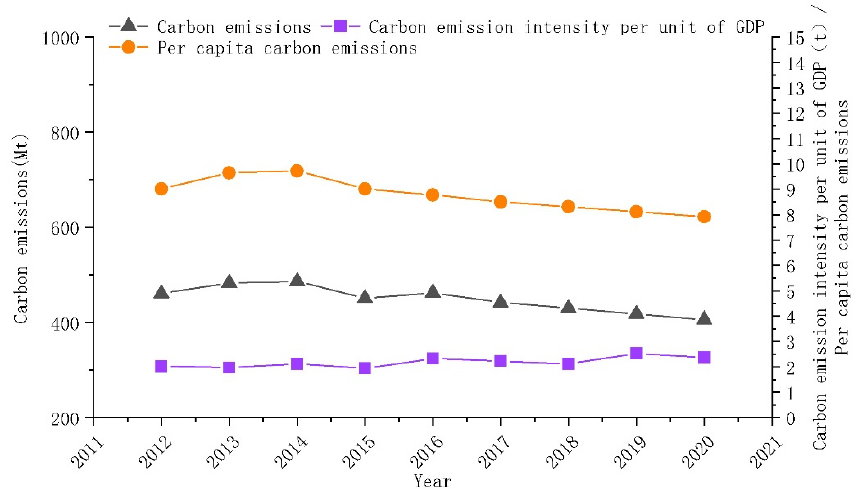
Figure 5. Changes in county-level carbon emissions, per capita carbon emissions, and carbon intensity in Northeast China 2012–2020.